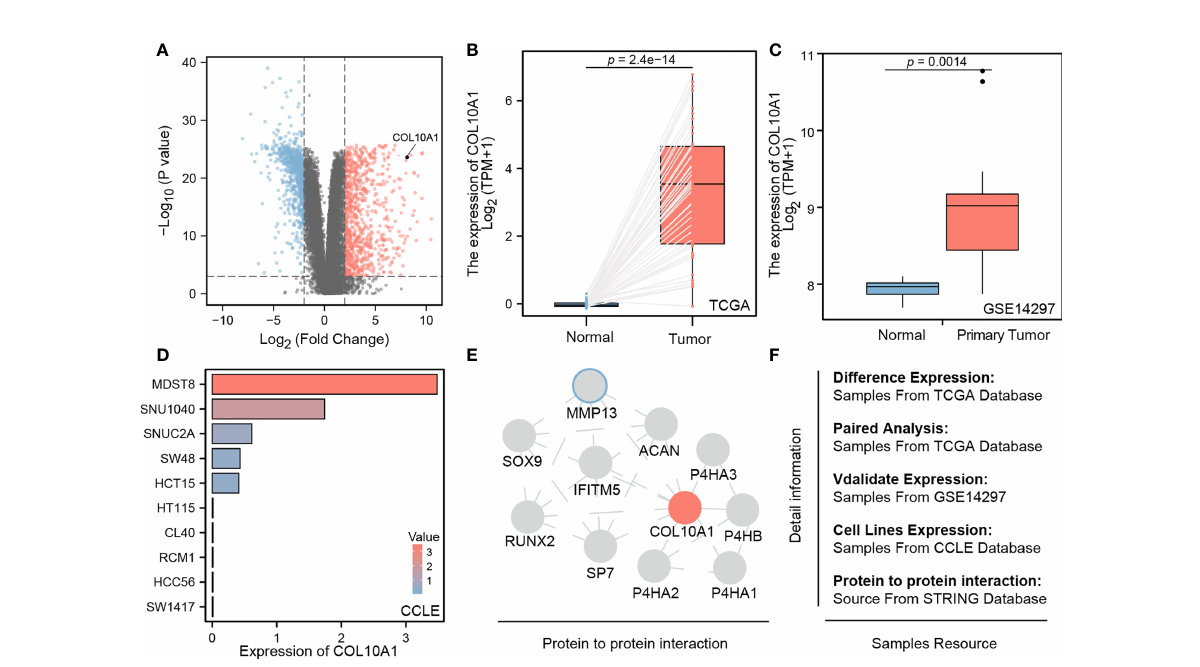
FIGURE 1 (A) COL10A1 upregulated mRNA levels in CRC tissues in comparison with all present genes; (B, C) paired sample expression validation of COL10A1 from TCGA and GSE14279; (D) different COL10A1 expression levels in common CRC cell lines; (E) microenvironmental protein – protein interaction of COL10A1; (F) data